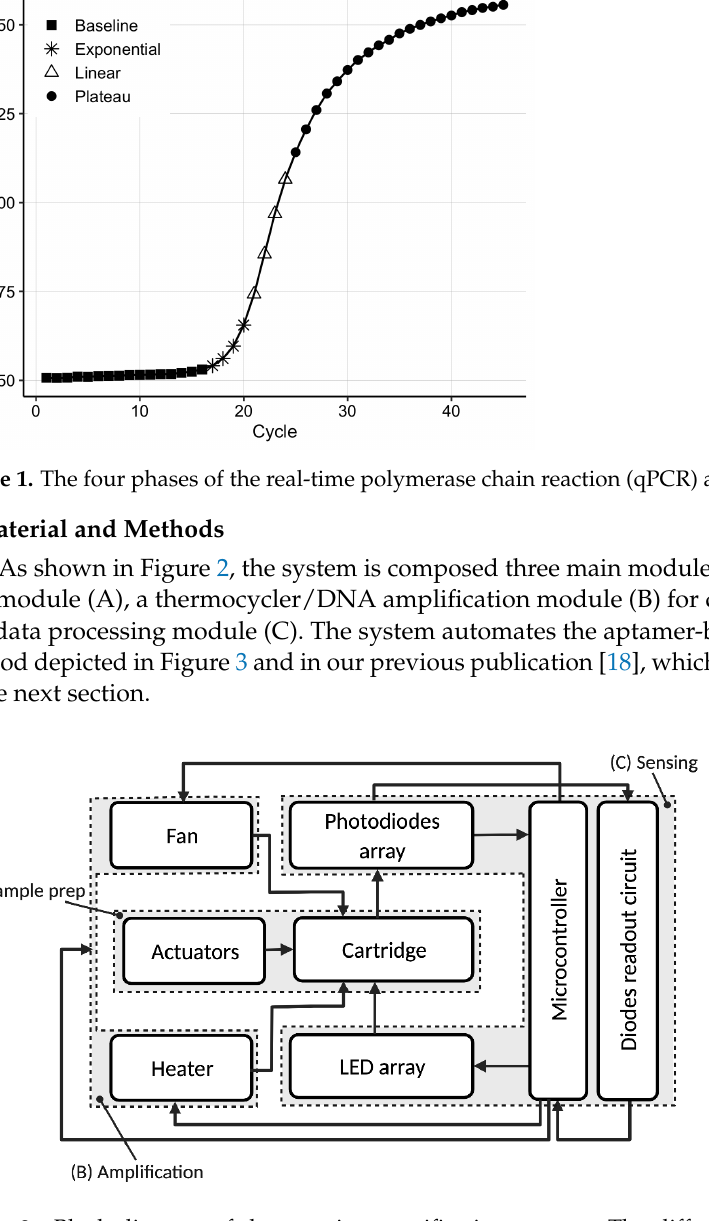
Figure 2. Block diagram of the protein quantification system. The different functional blocks are: (A) sample preparation; (B) thermocycler/DNA amplification; (C) sensing/data processing. Reprinted/adapted with permission from Ref. [17]. 2021,